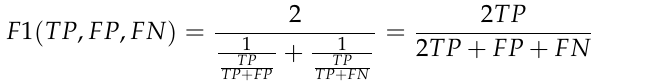
Table 2. Training parameters.